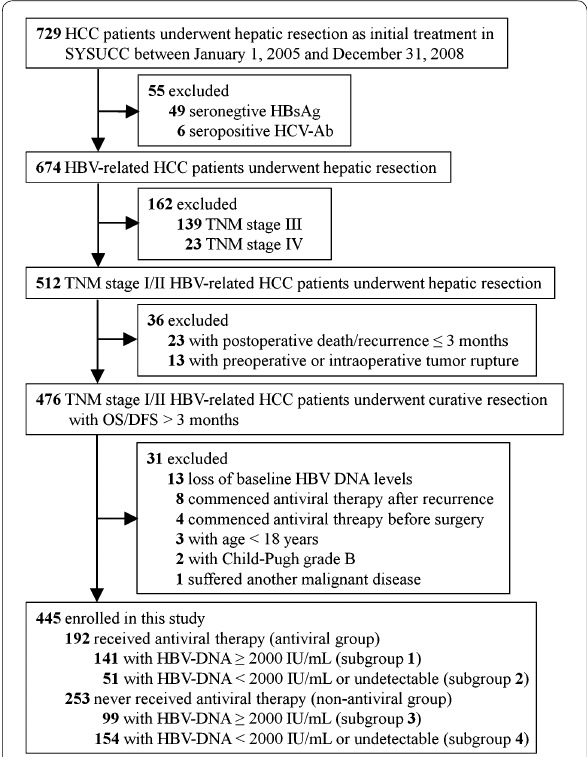
Fig. 1 Selection of patients with early stage HBV‑related HCC under‑ going curative resection. HCC hepatocellular carcinoma, SYSUCC